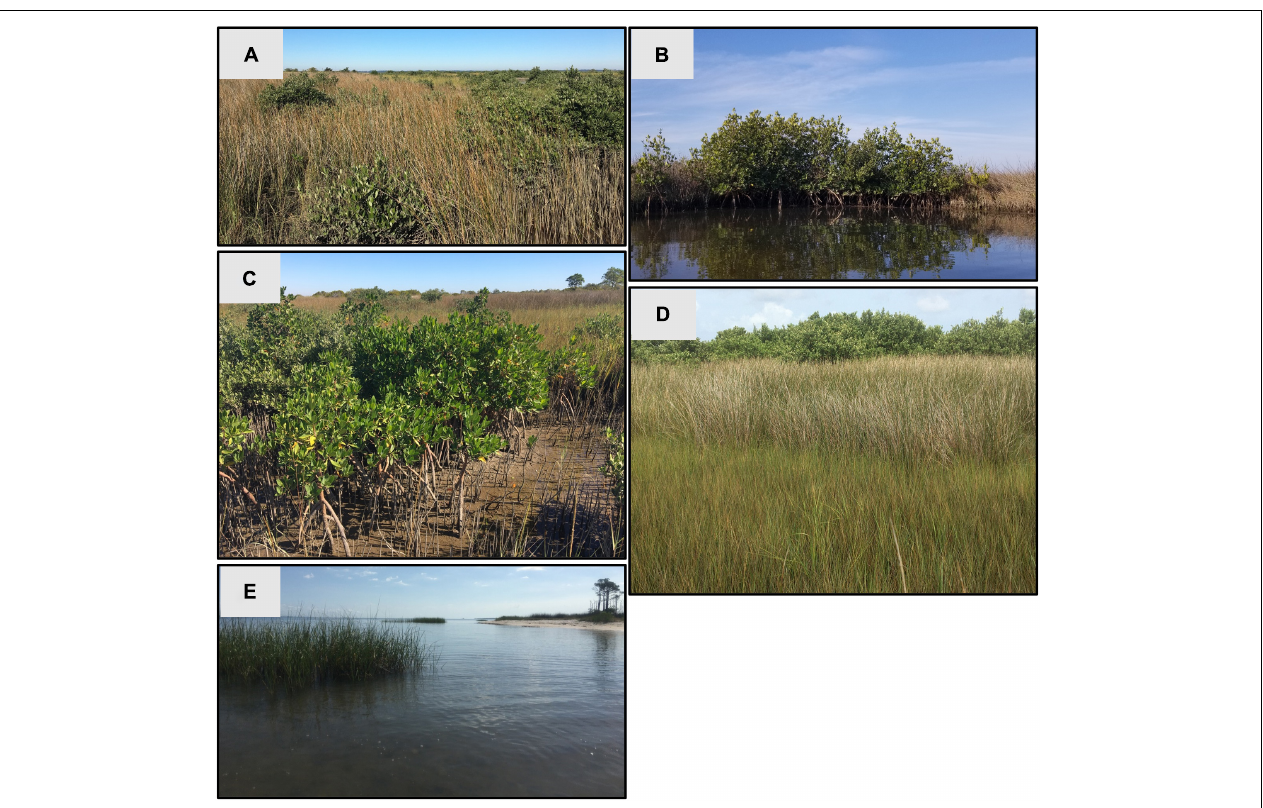
FIGURE 5 | Regional photos of neighboring vegetation types. (A) Shows A. germinans replacement of J. roemerianus on Dog Island; (B) shows R. mangle replacement of J. roemerianus at Pilot’s Cove. (C) Shows A. germinans and R. mangle adjacent to S. alterniflora on Dog Island. (D) Shows S. alterniflora in the foreground, J. roemerianus in the middle, and A. germinans in the background at Pilot’s Cove. (E) Shows patches of S. alterniflora being inundated and isolated by sea-level rise at Unit